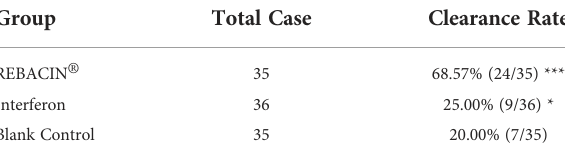
TABLE 1 Ef fi cacy of REBACIN ® on the clearance of hrHPV E6/E7 mRNA.